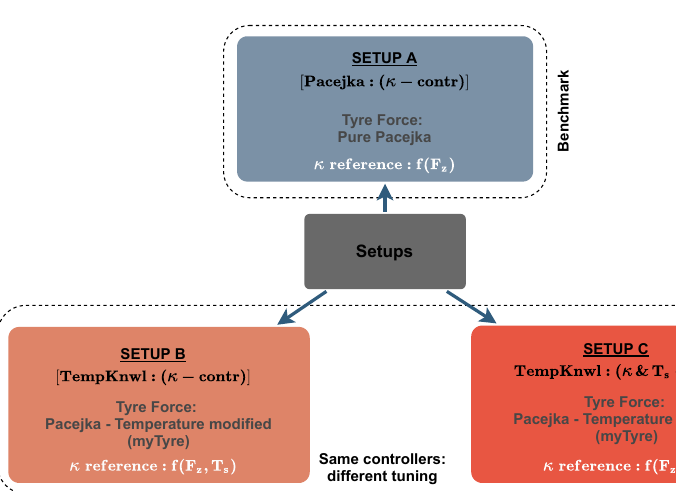
Figure 21. Controller